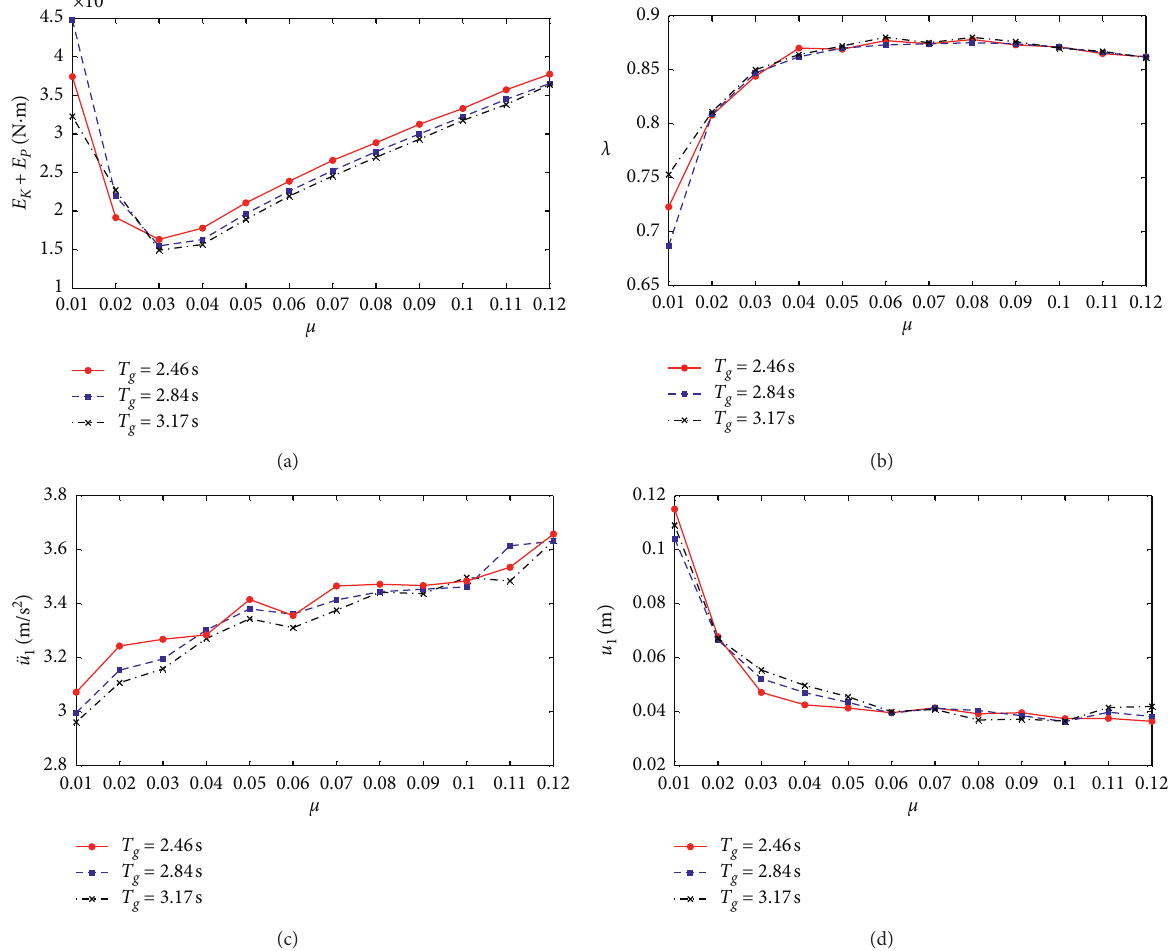
Figure 14: Seismic response amplitude (El Centro, peak acceleration 0.3 g ). (a) Structural response energy; (b) energy consuming ratio; (c) acceleration amplitude of the main beam; (d) displacement amplitude of the main